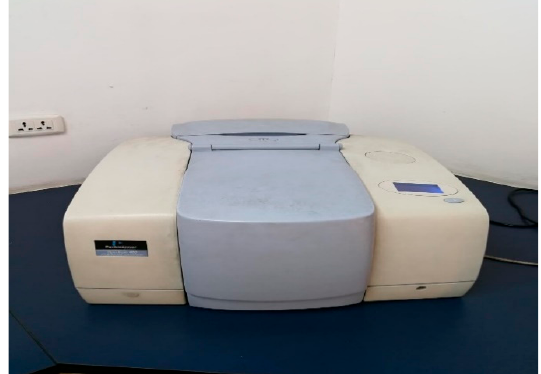
Figure 7. Fourier red infrared spectrum tester.